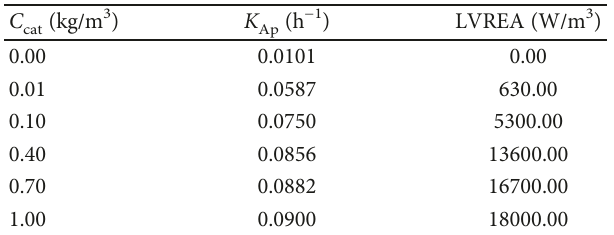
Figure 11: Test for a pseudo fi rst-order kinetics as a function of concentration. Table 3: First-order kinetic constants and values of LVREA at di ff erent catalyst loadings.